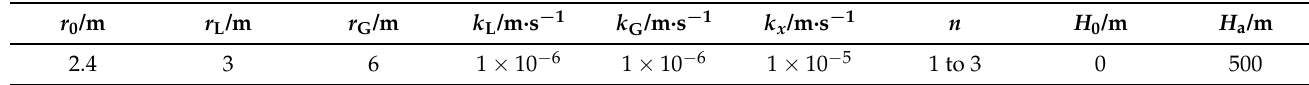
Figure 3. Finite element limit analysis model and meshing. ( a ) Calculation model. ( b ) Adaptive meshing. Table 1. Calculation parameters in numerical simulation.